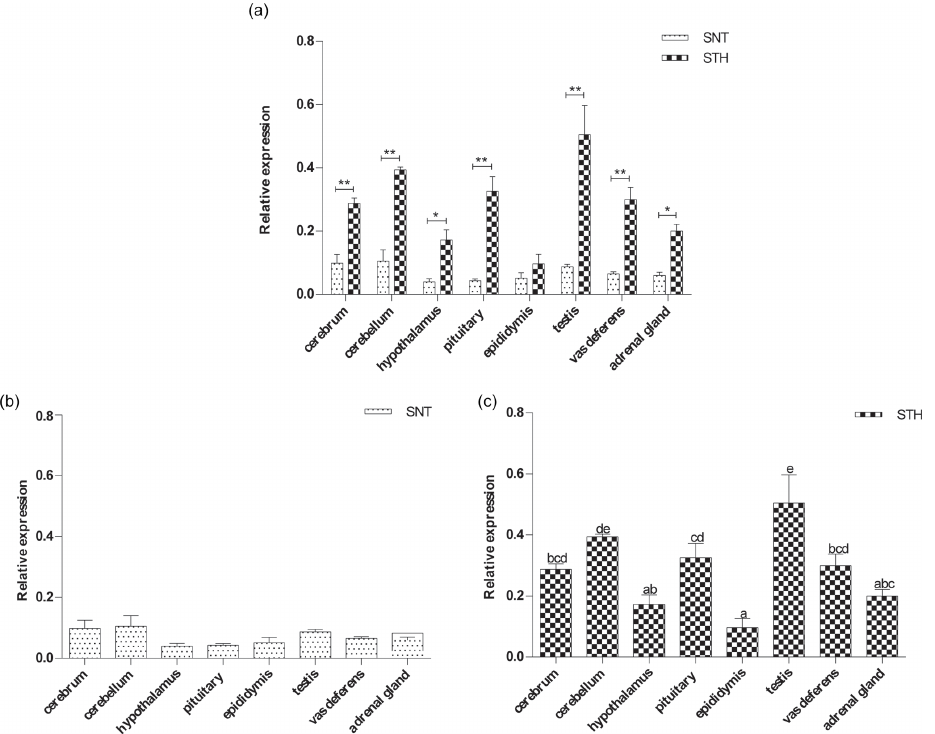
Figure 3. The expression of GPR54 in eight tissues of small-tail Han sheep (STH) and Sunite sheep (SNT): (a) the comparison of the ex- pression between SNT and STH, (b) the expression in SNT and (c) the expression in STH. Means with different superscripts are significantly different ( P < 0 . 05). The significant results with a p value lower than 0.05 are given one asterisk ( ∗ ) and lower than 0.01 are given two asterisks ( ∗∗ ),